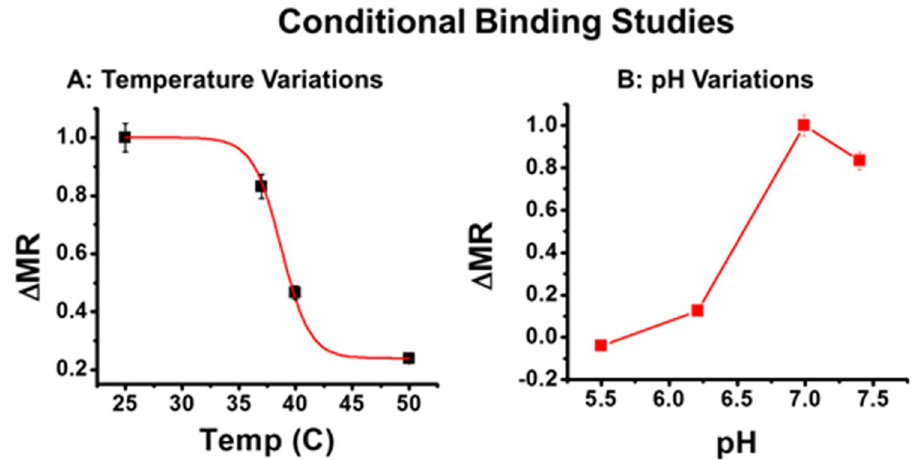
Figure 5. Effects of ( A ) temperature and ( B ) pH on binding between ZENV-MRNPs and AXL. Average values of three measurements are depicted ± standard